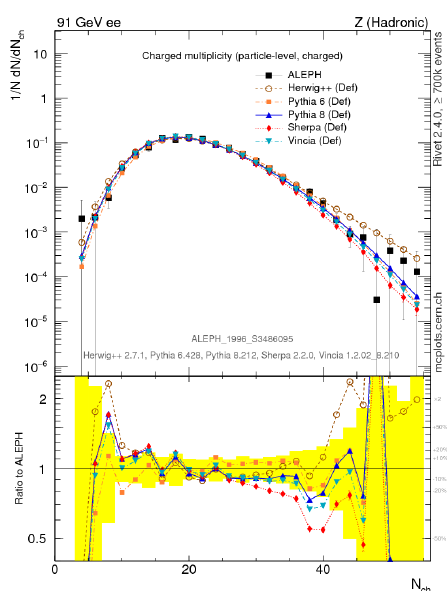
Figure 2: New users per day on Test4Theory during 2012 (upper) and comparison of modern event generators to a legacy measure- ment (lower, from the MCPlots web site